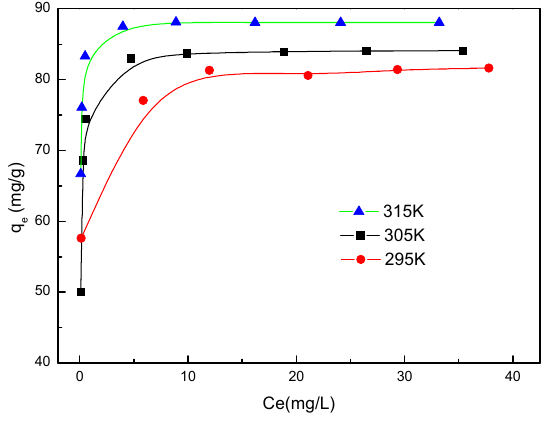
Figure 8. Adsorption isotherms of Pd(II) at different temperatures.